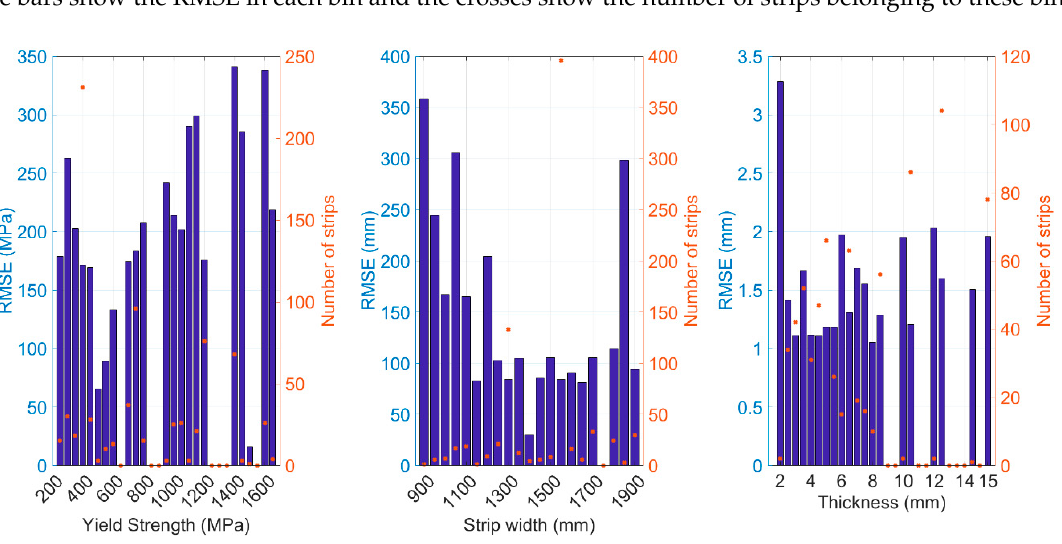
Figure 11. RMSE of models fitted on the complete data set of 752 steel strips in bins.